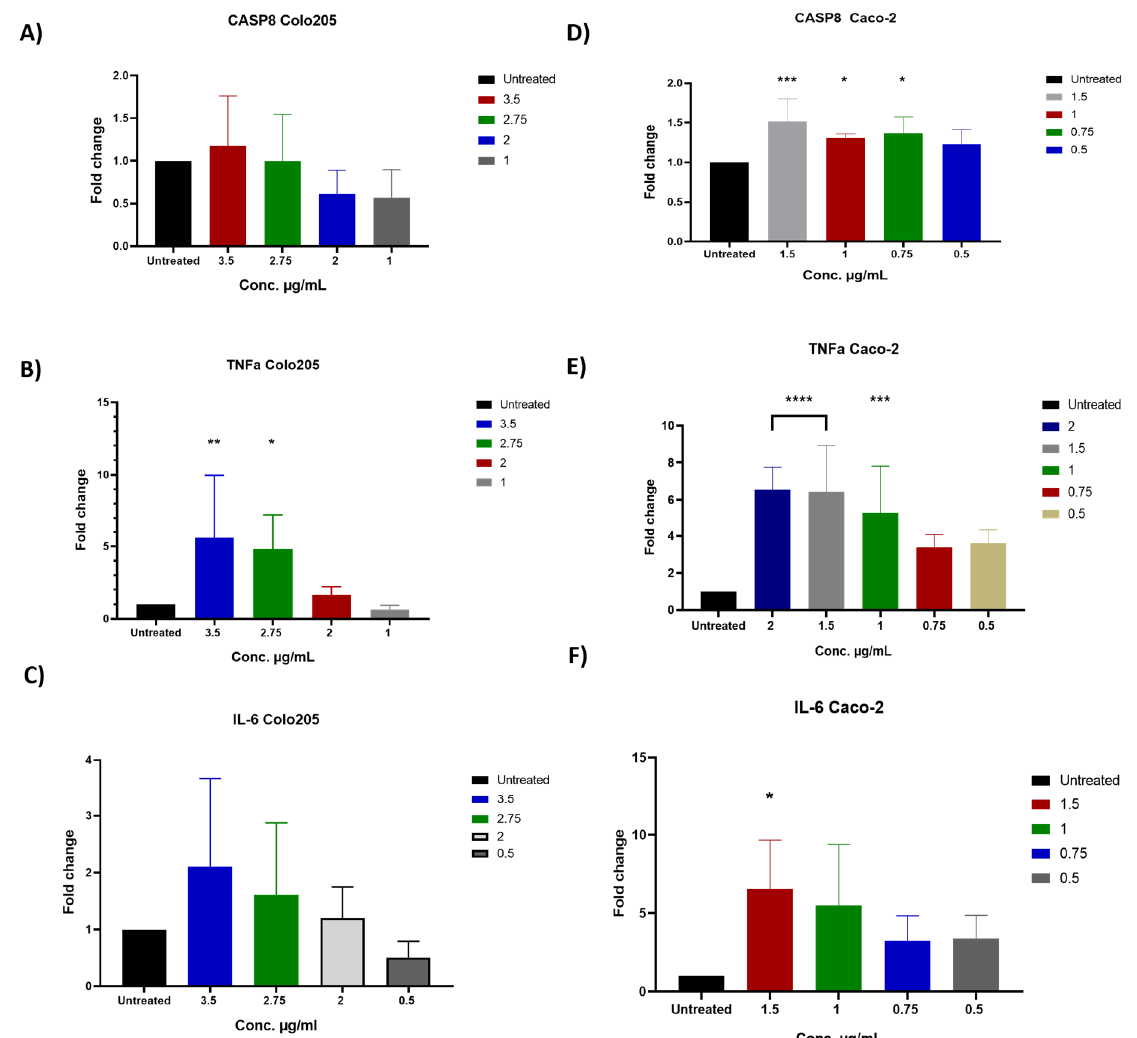
Figure 6. Gene expression analysis of apoptotic initiator gene CASP8 and two inflammatory cytokine genes TNF-α and IL-6 in COLO-205 and Caco-2 cells after treatment with various concentrations of D. maritima (DM) bulb extract for 48 h as examined by quantitative RT–PCR: ( A , D ) The graphs reveal fold changes in the expression of CASP8 in COLO-205 and Caco-2 cells, respectively. ( B , E ) TNF-α gene in COLO-205 and Caco-2 cells at various extract concentrations (2.0, 1.5, 1.0, 0.75, and 0.5 µg/mL). ( C , F ) IL-6 in COLO-205 and Caco-2 cells treated with different extract concentrations (1.5, 1.0, 0.75, and 0.5 µg/mL). Fold change was calculated using the ΔΔCt method. Untreated cells were used as the control; therefore, the fold change for untreated cells is 1 in all plots. GAPDH gene served as an internal reference gene. The error bars indicate the standard deviation from triplicate experiments (* p <0.05; ** p <0.01; *** p <0.001).